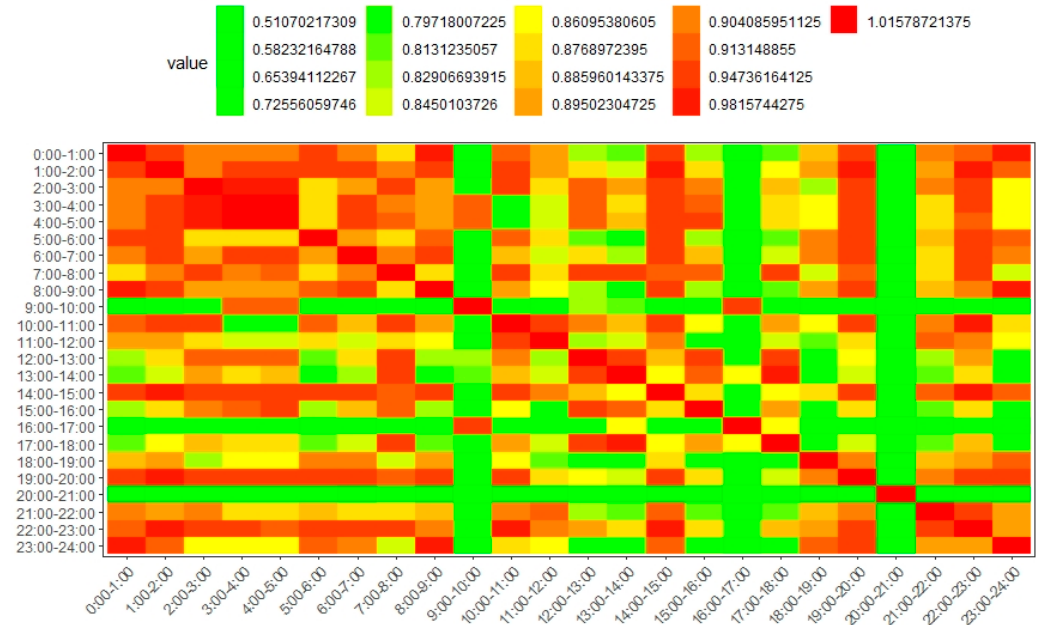
Figure 11. Similarity of the community structures in different time periods with 500 m cell size.